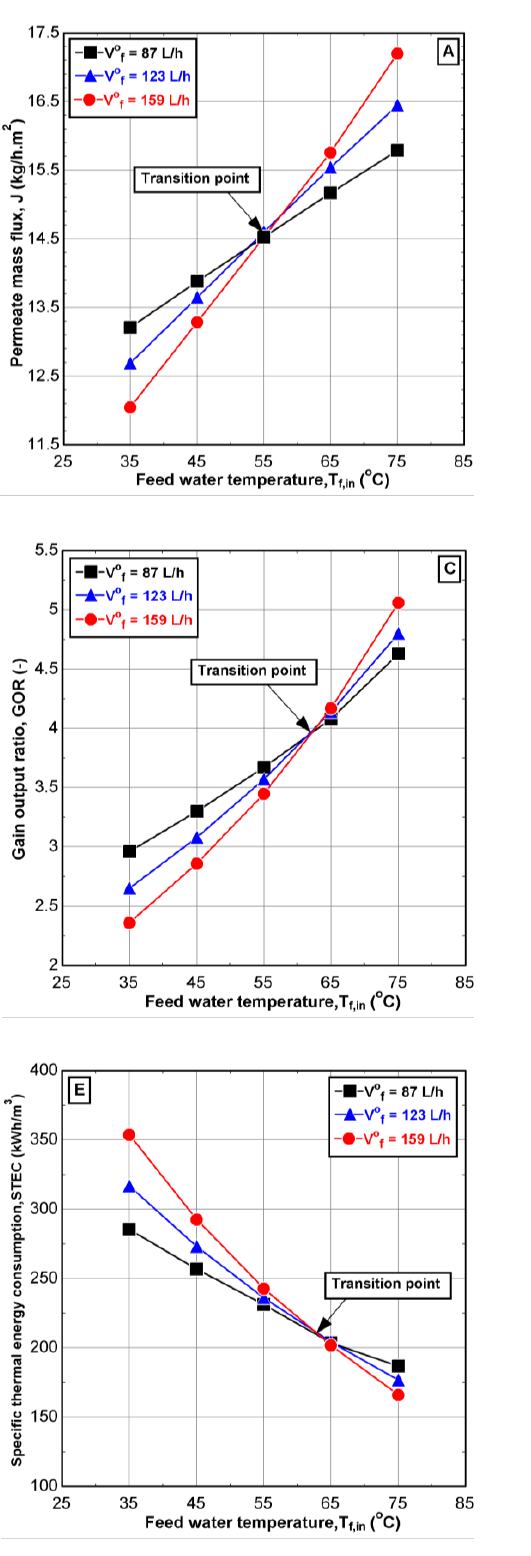
Figure 11. Effect of feed water temperature T f , in on ( A ) permeate mass flux, ( B ) recovery ratio, ( C ) gain output ratio, ( D ) performance ratio, ( E ) specific thermal energy consumption, and ( F ) specific electrical energy consumption for different . . V h = 840 L/h, T h , in = 75 ◦ C, V c = 405 L/h, T c , in = 20 ◦ C, w = 1260 ppm, and P a , vac = 115 feed water flowrates (